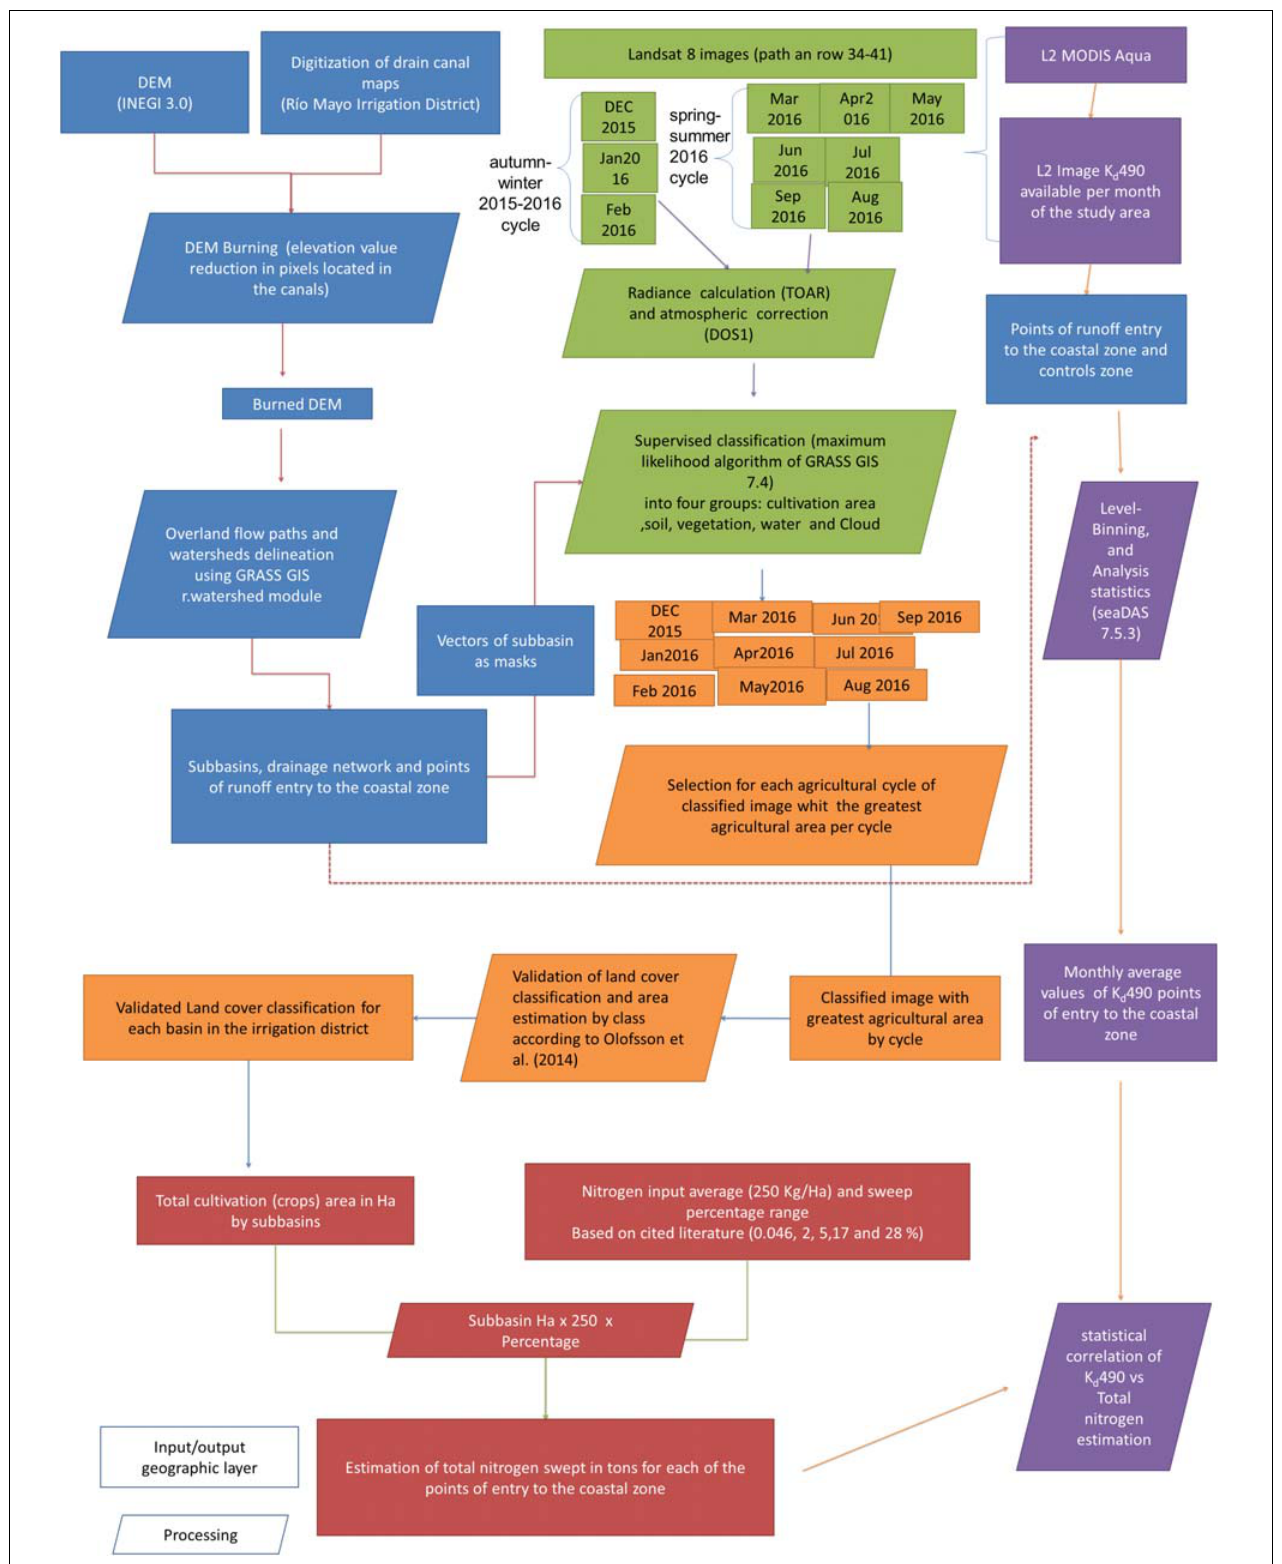
FIGURE 2 | Methodology flowchart for estimating nitrogen runoff from crops to the coastal zones.